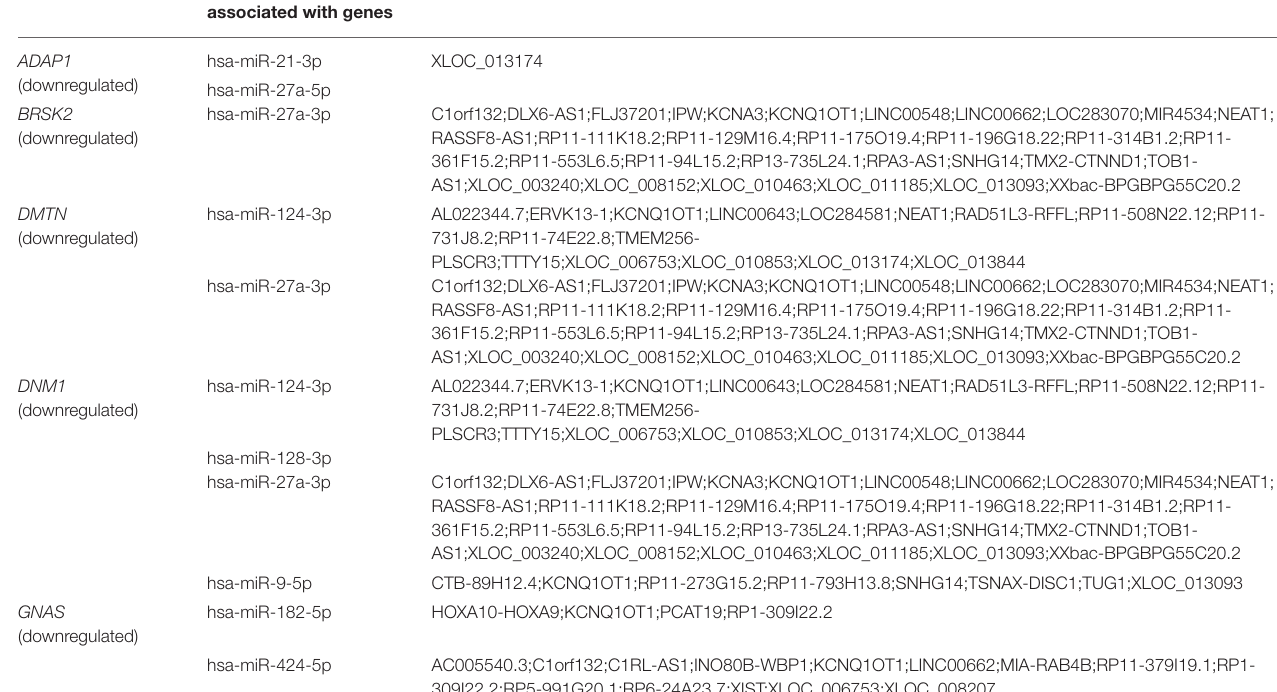
TABLE 7 | AD-associate miRNAs associated with the AD-associate DEGs. AD-associate DEGs AD-associate miRNAs lncRNAs associated with associated with genes